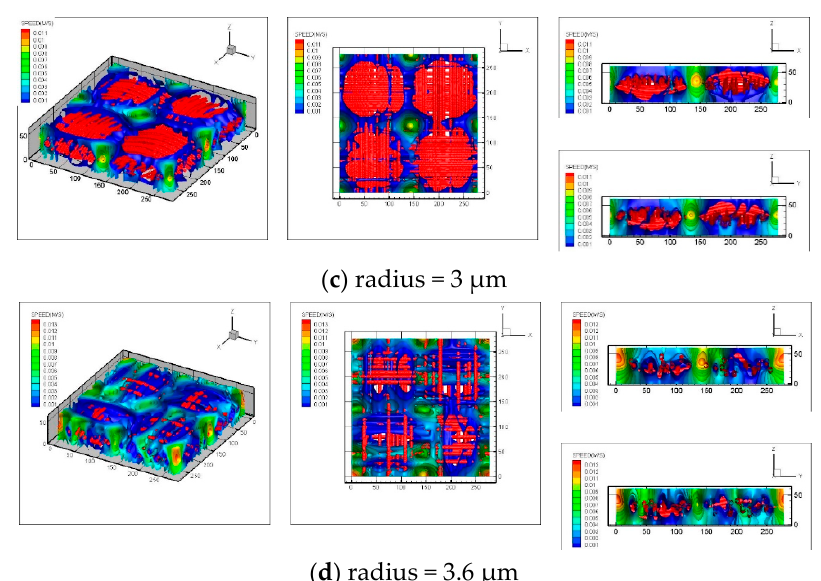
Figure 12. The simulated velocity fields of carbon cloth GDLs with di ff erent fiber radii (porosity = 0.81). Figure 12. ( a – d ) The simulated velocity fields of carbon cloth GDLs with different fiber radii (porosity ( a ) radius = 2.1 µ m ( b ) radius = 2.7 µ m ( c ) radius = 3 µ m ( d ) radius = 3.6 µ = 0.81).